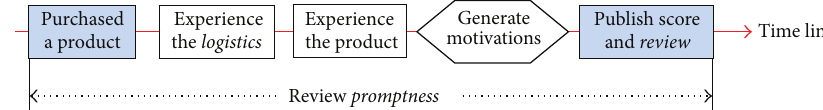
Figure 1: The birth of an online review.